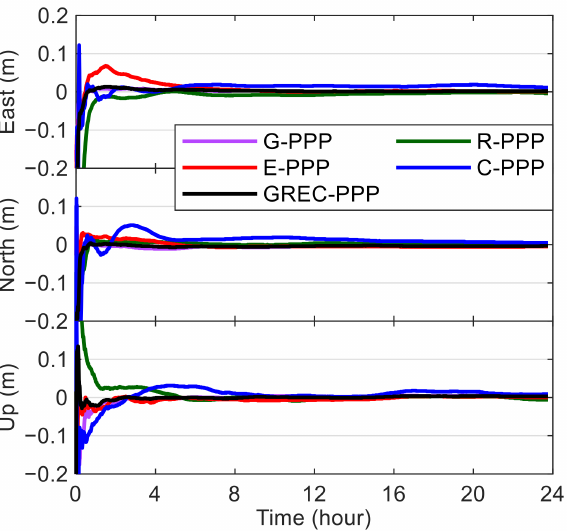
Figure 11. Epoch-wise position errors of static PPP using CNES real-time precise products at station